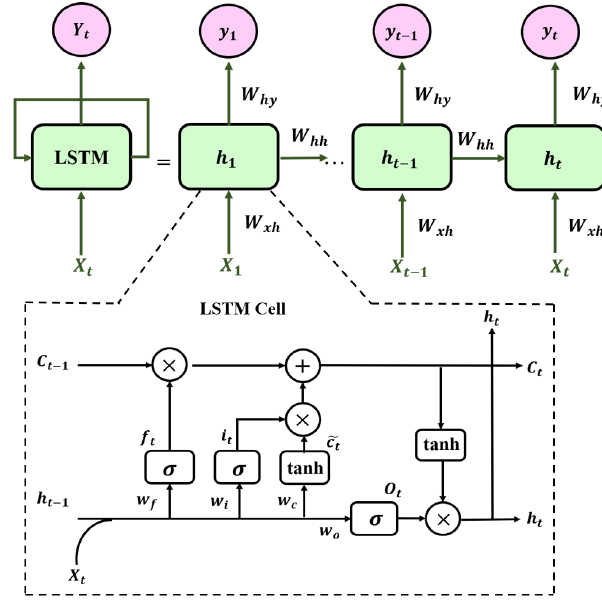
Figure 6. LSTM network